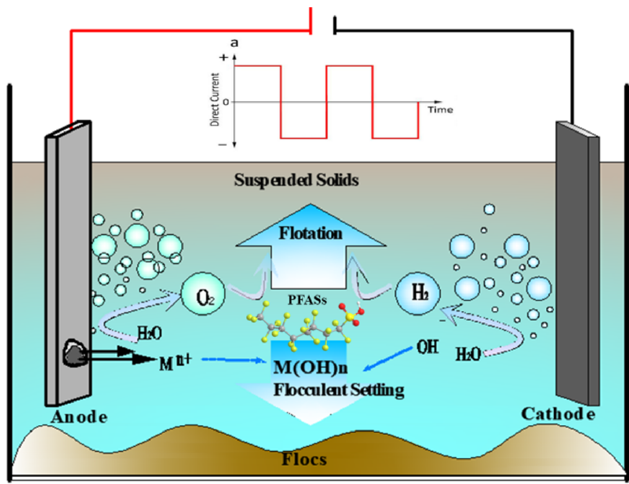
Figure 2. Electrocoagulation Mechanism for PFASs removal. Table 2. Comparisons on adsorption capacities of various adsorbents for short-chain